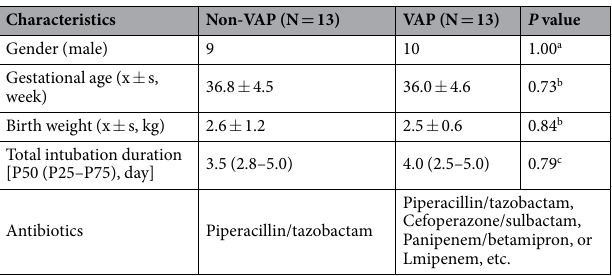
Table 3. Comparison of demographic and clinical characteristics between non-VAP and VAP infants among neonates with pneumonia in the study. a Based on Fisher’s exact test. b Based on unpaired Student’s t-test. c Based on Mann–Whitney U test.